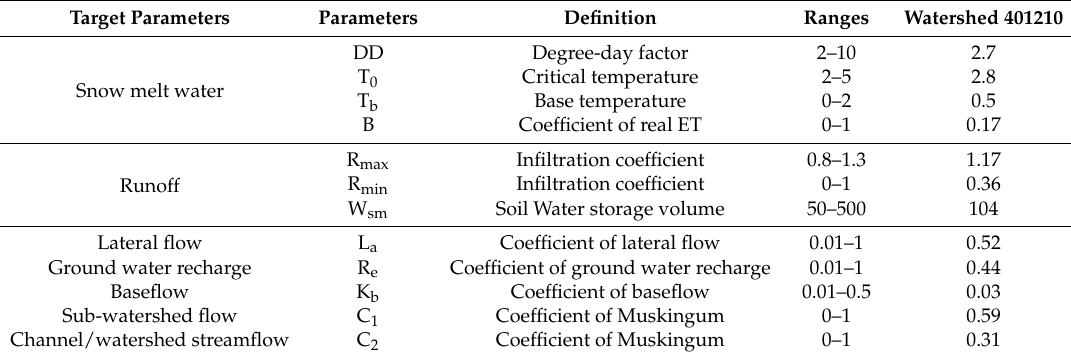
Table 2. Parameters of HIMS for adjustment and values in the calibration